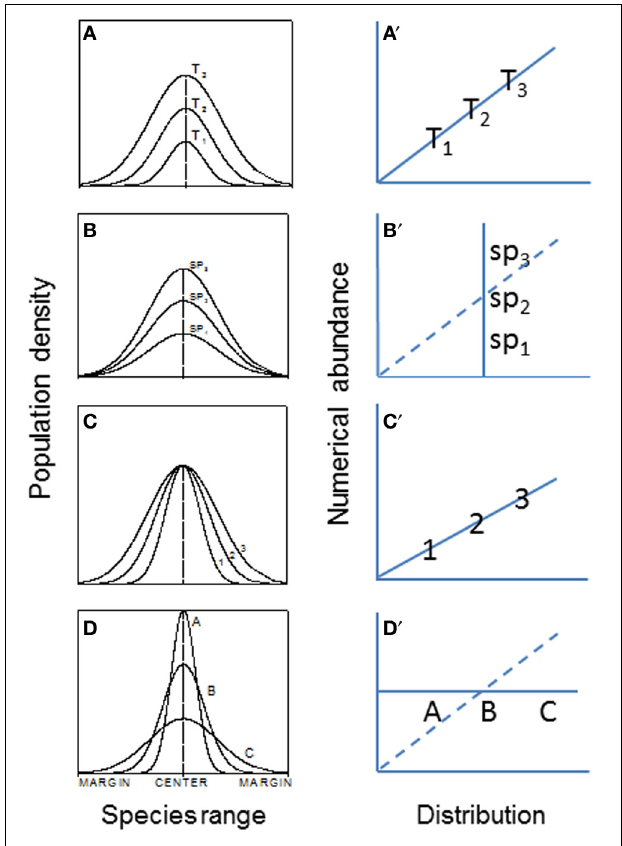
FIGURE 5 | The hypothesized patterns of abundance (population density) and abundance-distribution relationships across patches or species ranges (Veldtman et al., 2010). (A) The most common form where both abundance and range simultaneously increase with time, i.e., habitat and climate conditions are not limiting in the invaded ranges (e.g., the historical spread of muskrats, Ondatra zibethicus , in central Europe; see Figure 1 ). (B) Habitat area is highly limited but climate conditions are favorable. (C) Habitat area is not limited but climate is. (D) Combined scenarios of (A–C) . The right panels ( A’–D’) are corresponding relationships between abundance and distribution.